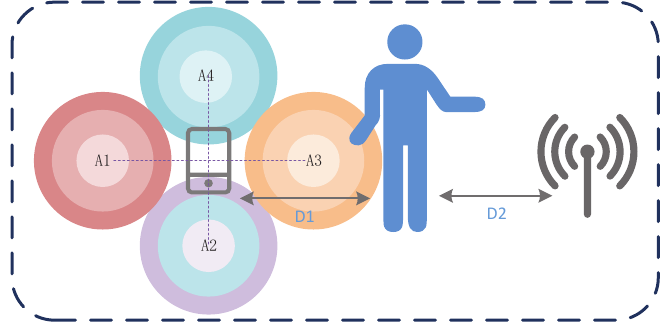
Figure 11. Different positions and regions of gestures input.